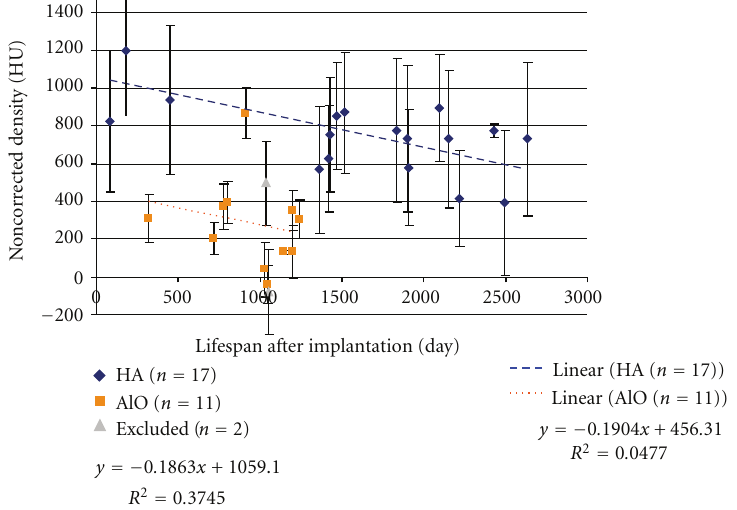
Figure 10: Scatter plot of the time between implantation and the HU (density) with conventionally noncalibrated and corrected plots.